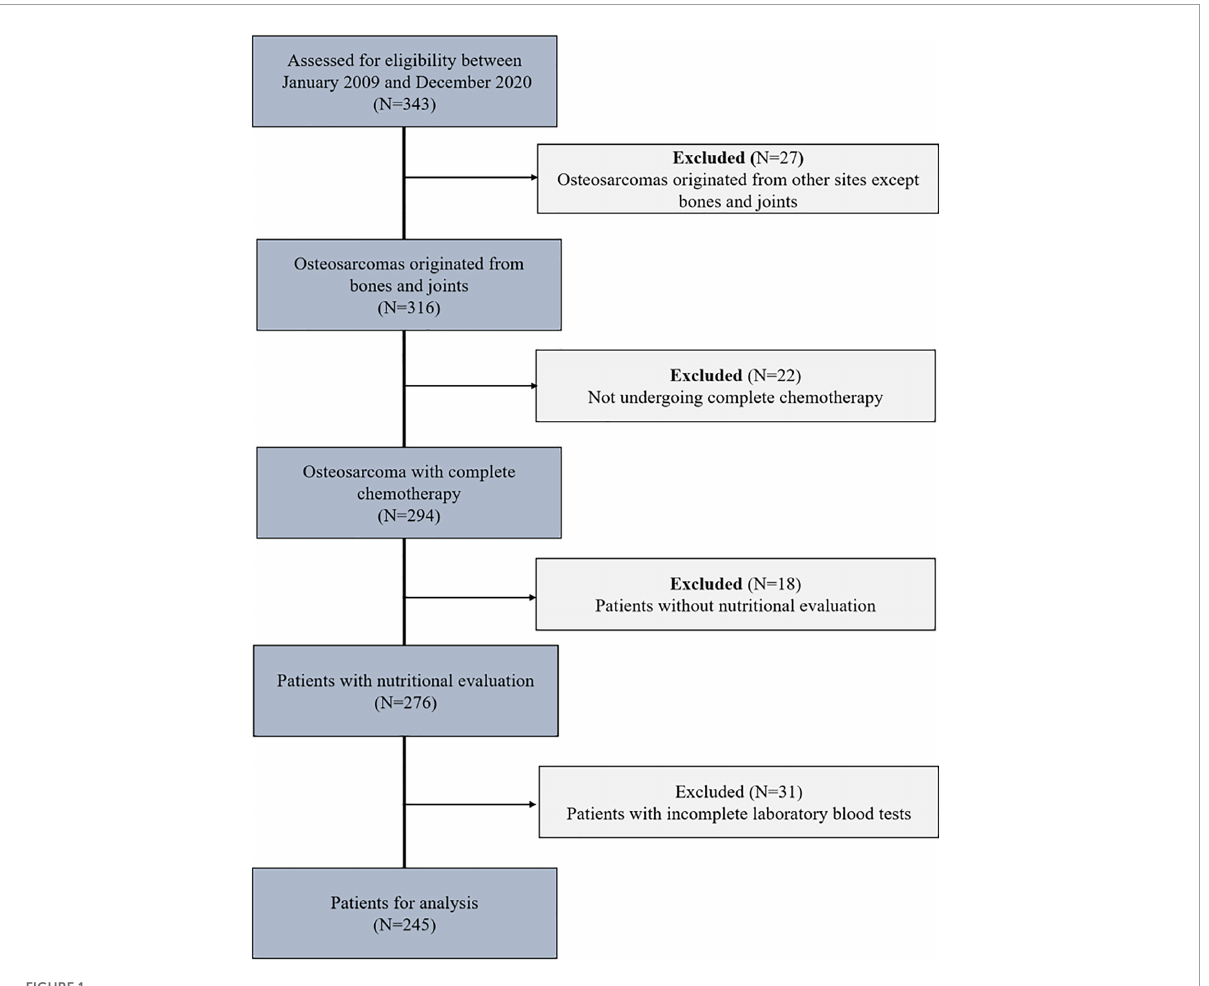
FIGURE1 Flowchart of the enrolled